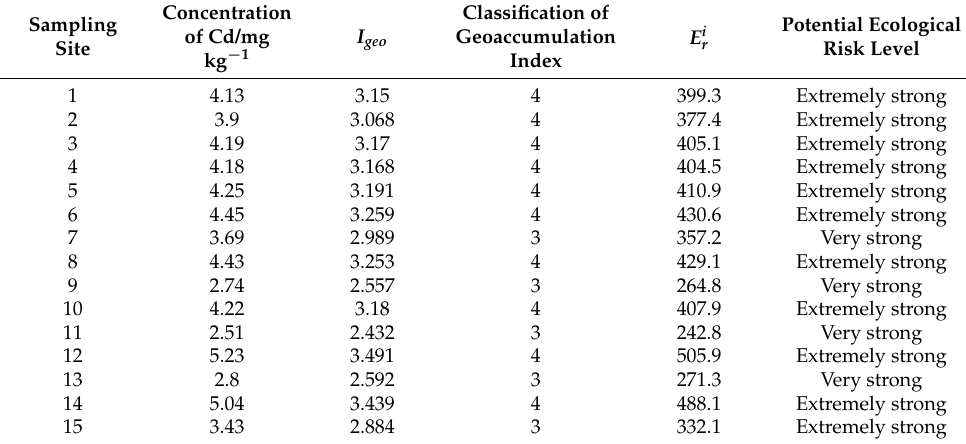
Table 7. Concentration and evaluation results of Cd in sediments at the Yelang